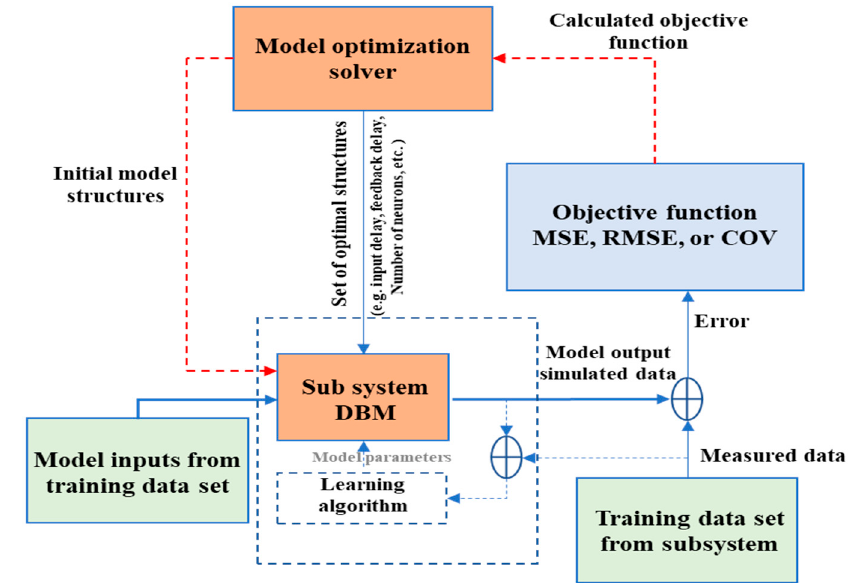
Figure 2. Proposed model level optimization strategy.